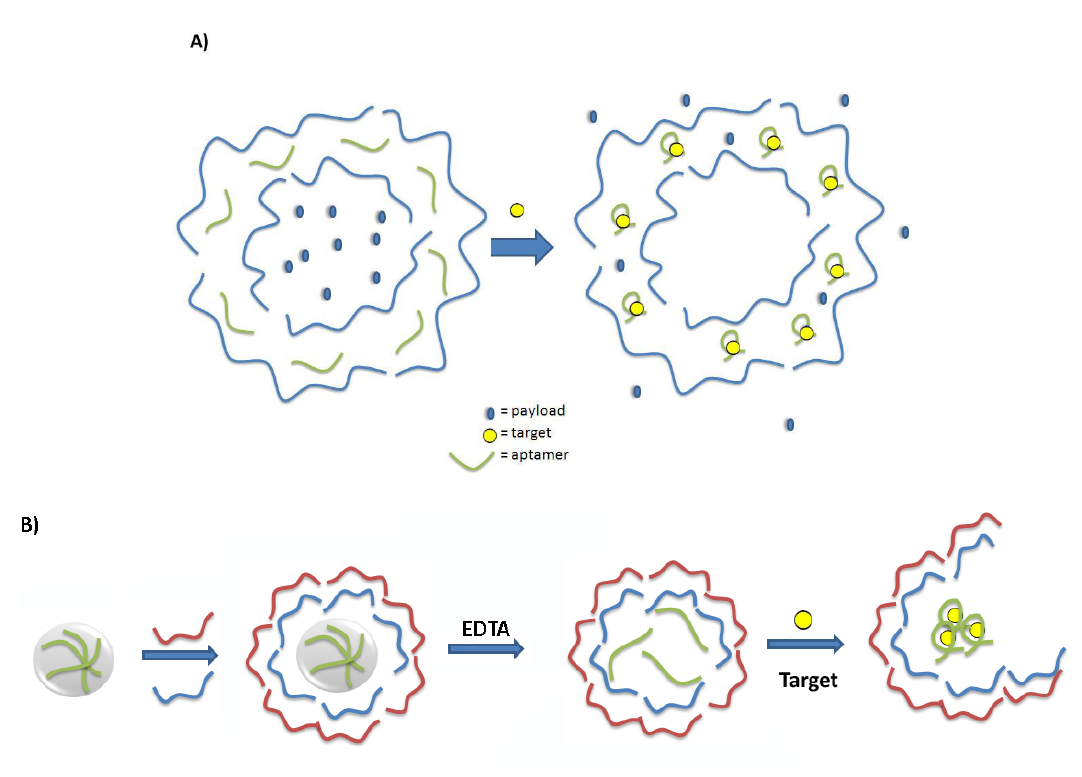
Figure 7. Model smart aptamer-polyelectrolyte microcapsule systems. ( A ) Target (yellow circles) binding to the aptamer (green) within the polyelectrolyte walls of the microcapsule (blue) leads to a change in permeability and release of the microcapsule’s payload (blue ovals). ( B ) Aptamers (green) are doped within the sacrificial spherical templates upon which polyelectrolytes (red and blue) are deposited. Upon dissolution of the template, the aptamers support the structure of the polyelectrolyte microcapsule. Target binding (yellow ovals) compromises the structural integrity of the microcapsule and it ruptures. (modified from references